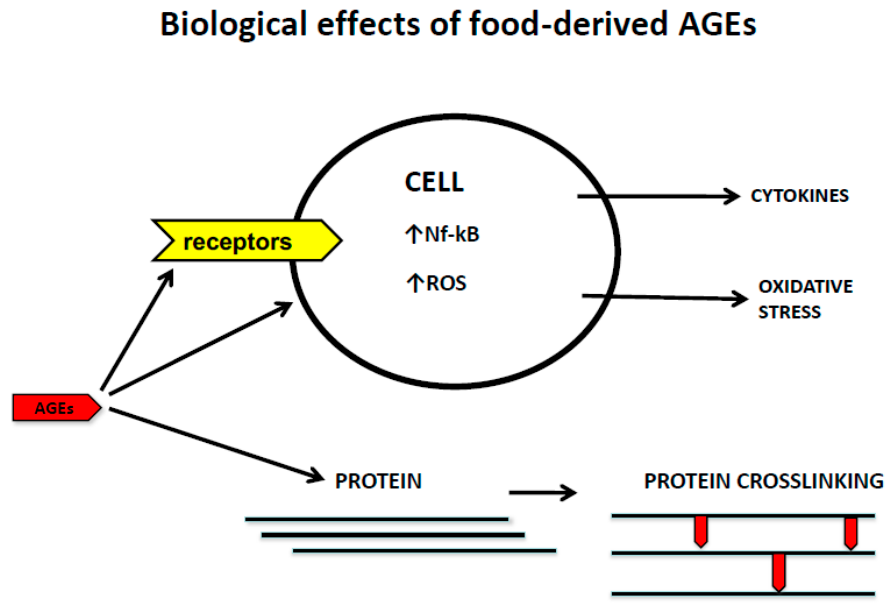
Figure 1. Biological effects of food-derived AGEs. ↑ refers to increased formation. AGEs produce biological effects through two general mechanisms. On the one hand they crosslink proteins, directly altering their structure and, therefore, their function. For example, glycation of collagen fibers in the skin and vessel walls changes the characteristics of these proteins and their holding tissues as explained within the manuscript. On the other hand, AGEs acting through receptor and non-receptor mechanisms activate different cells leading to increased OS and the release of pro-inflammatory